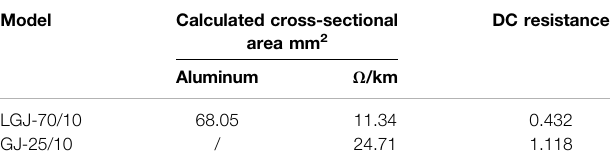
TABLE 1 | Voltammetry characteristics of MOA.